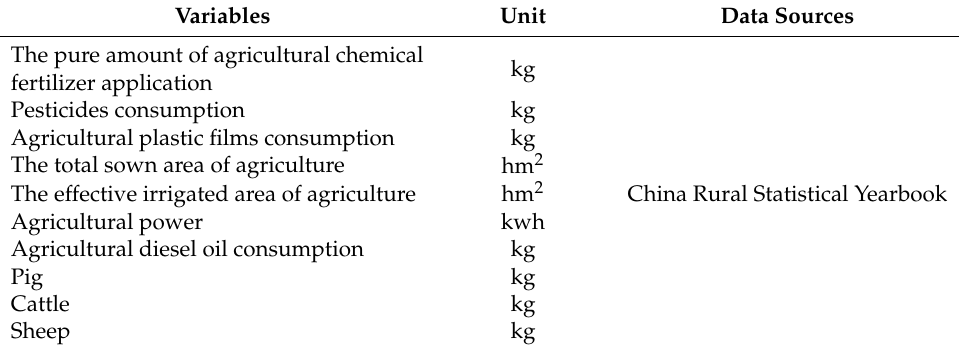
Table 1. Data sources.